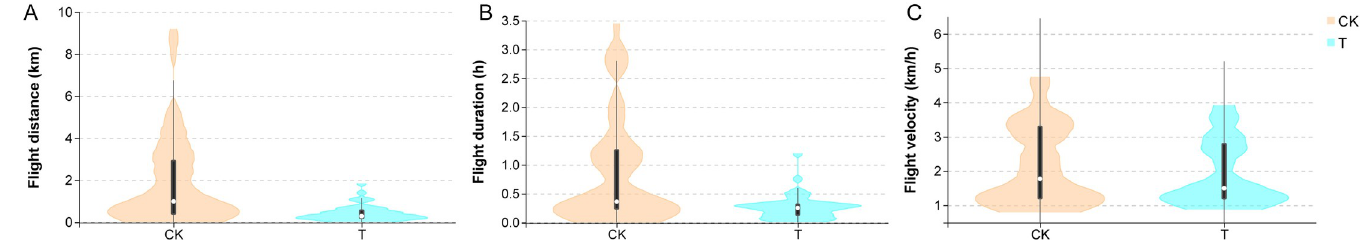
Fig 1. The effects of T . mercedesae infestation on flight ability of adult honey bee (n = 45). A: flight distance; B: flight duration; C: mean flight velocity. CK: non- infested honey bees; T: T . mercedesae -infested honey bees. Horizontally, the width of each violin box represents the density of the data values. The white dots represent the median values of each group. The upper and lower edges of the black thick line represent the 3/4 digits and 1/4 digits of the data. The upper and lower ends of the thin line represent the maximum and minimum values of non-outliers of the data.